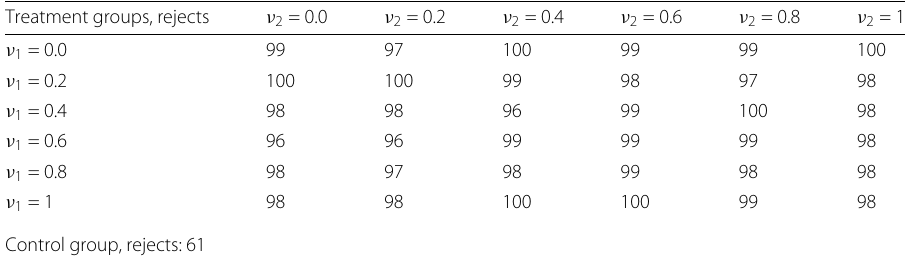
Table 3 Number of rejects (out of 100 runs) for goodness-of-fit tests of power-law models to in-degree distributions of interaction networks in online communities, with no onboarding (control group) and with onboarding Treatment groups, rejects ν 2 = 0.0 ν 2 = 0.2